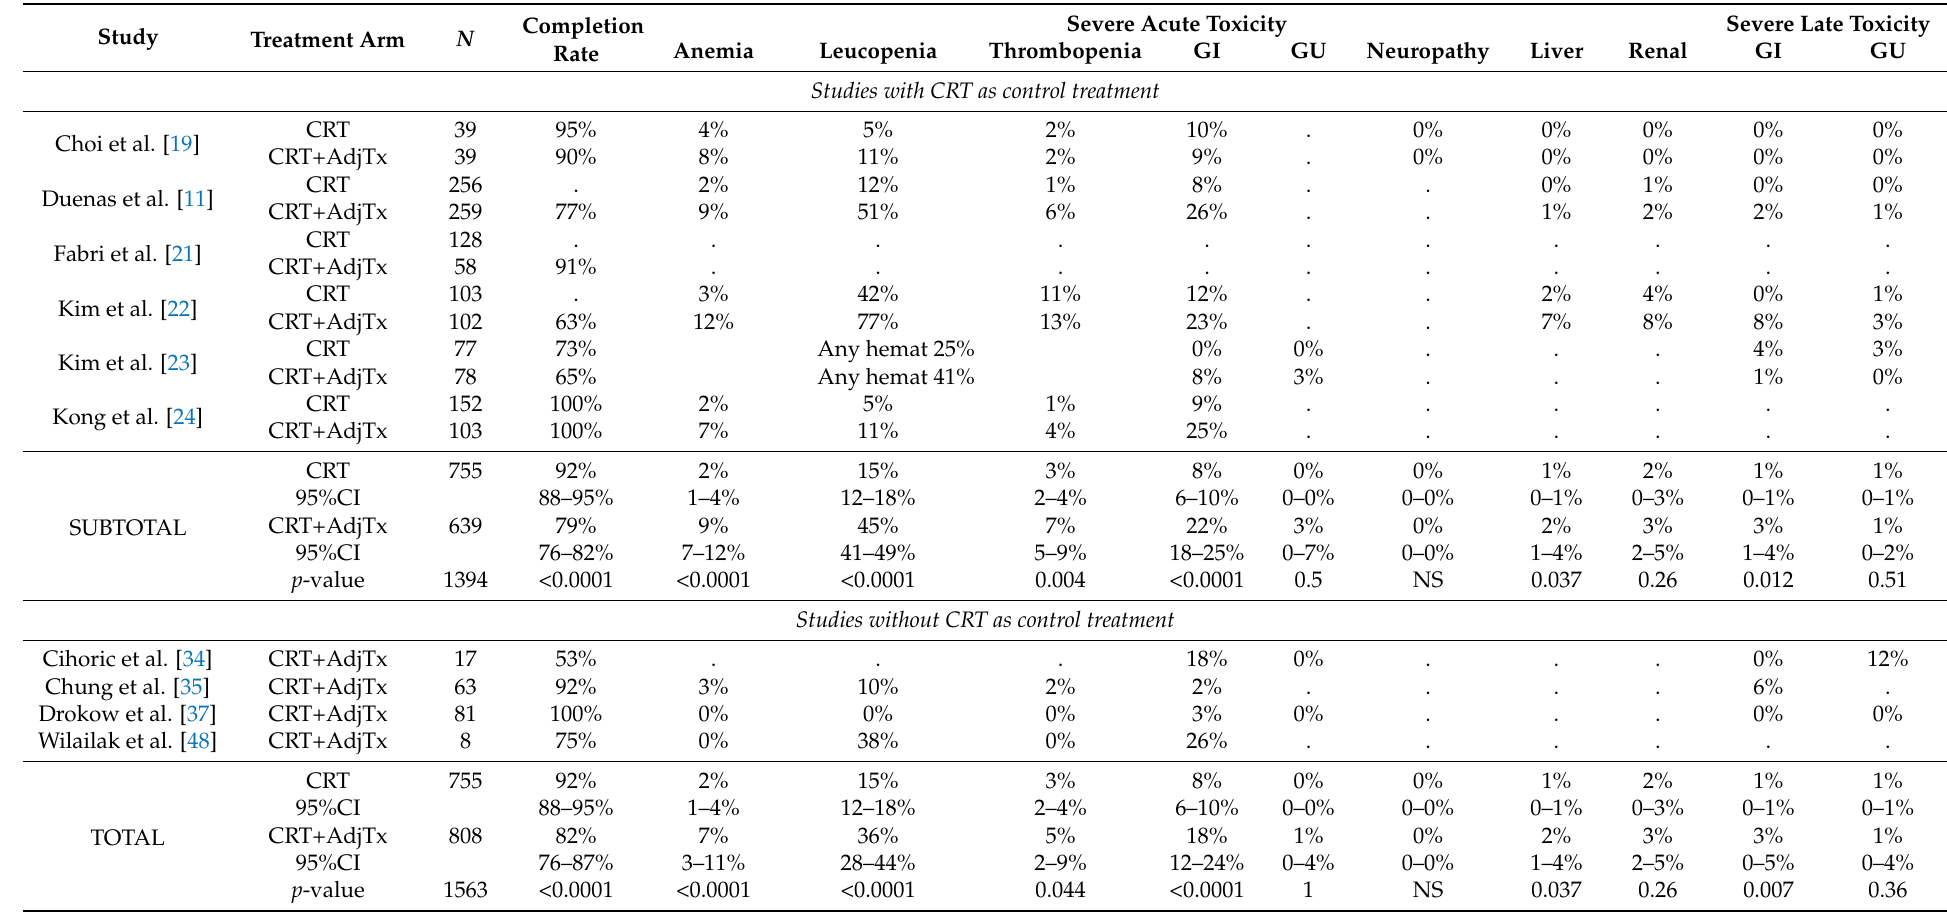
Table 3. Feasibility and toxicity of adjuvant platinum derivate and pyrimidine